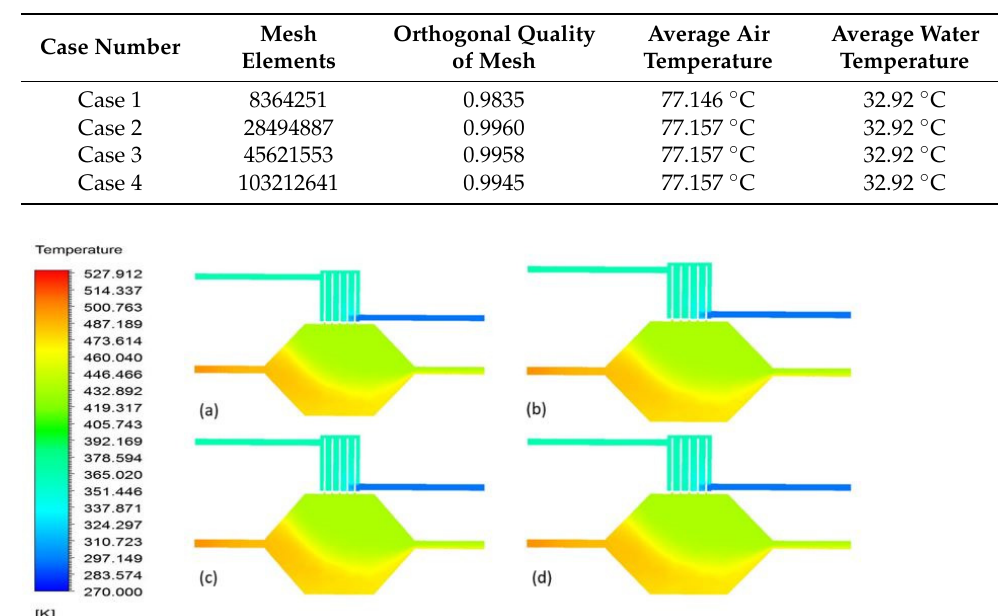
Table 1. Mesh independence study.